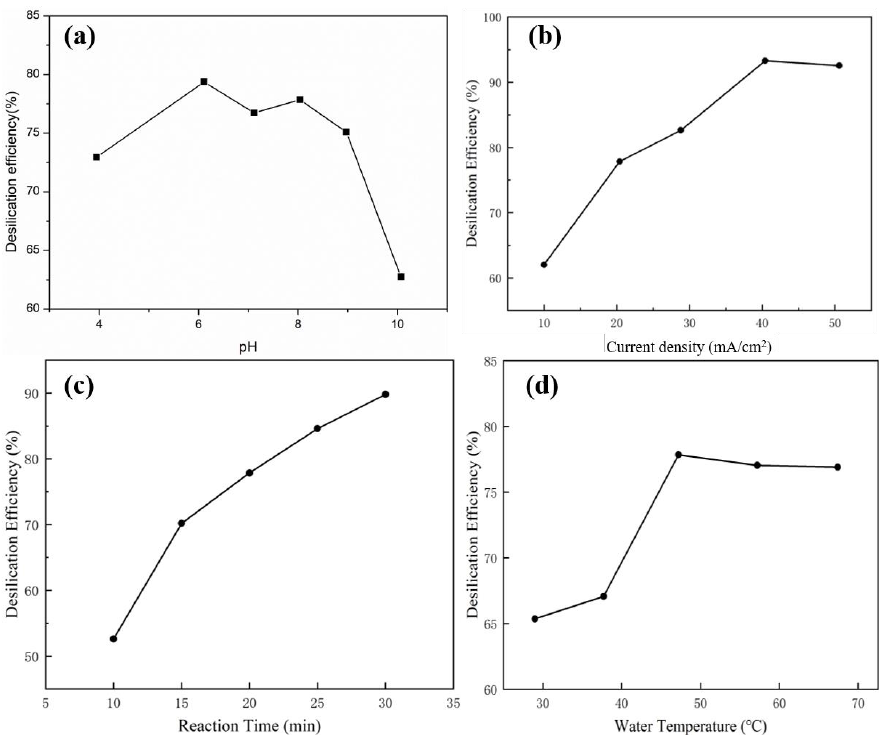
Figure 2. The impact of initial pH ( a ), current density ( b ), reaction time ( c ) and wastewater temperature ( d ) on silicon removal rate.